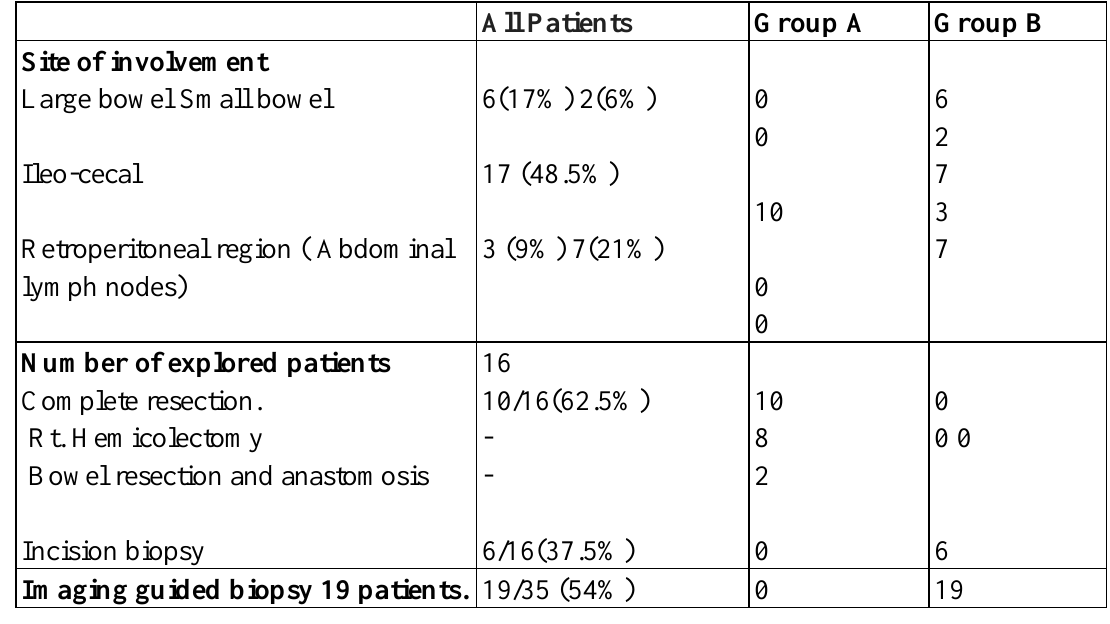
Table 5. Surgical Management of 35 abdominal